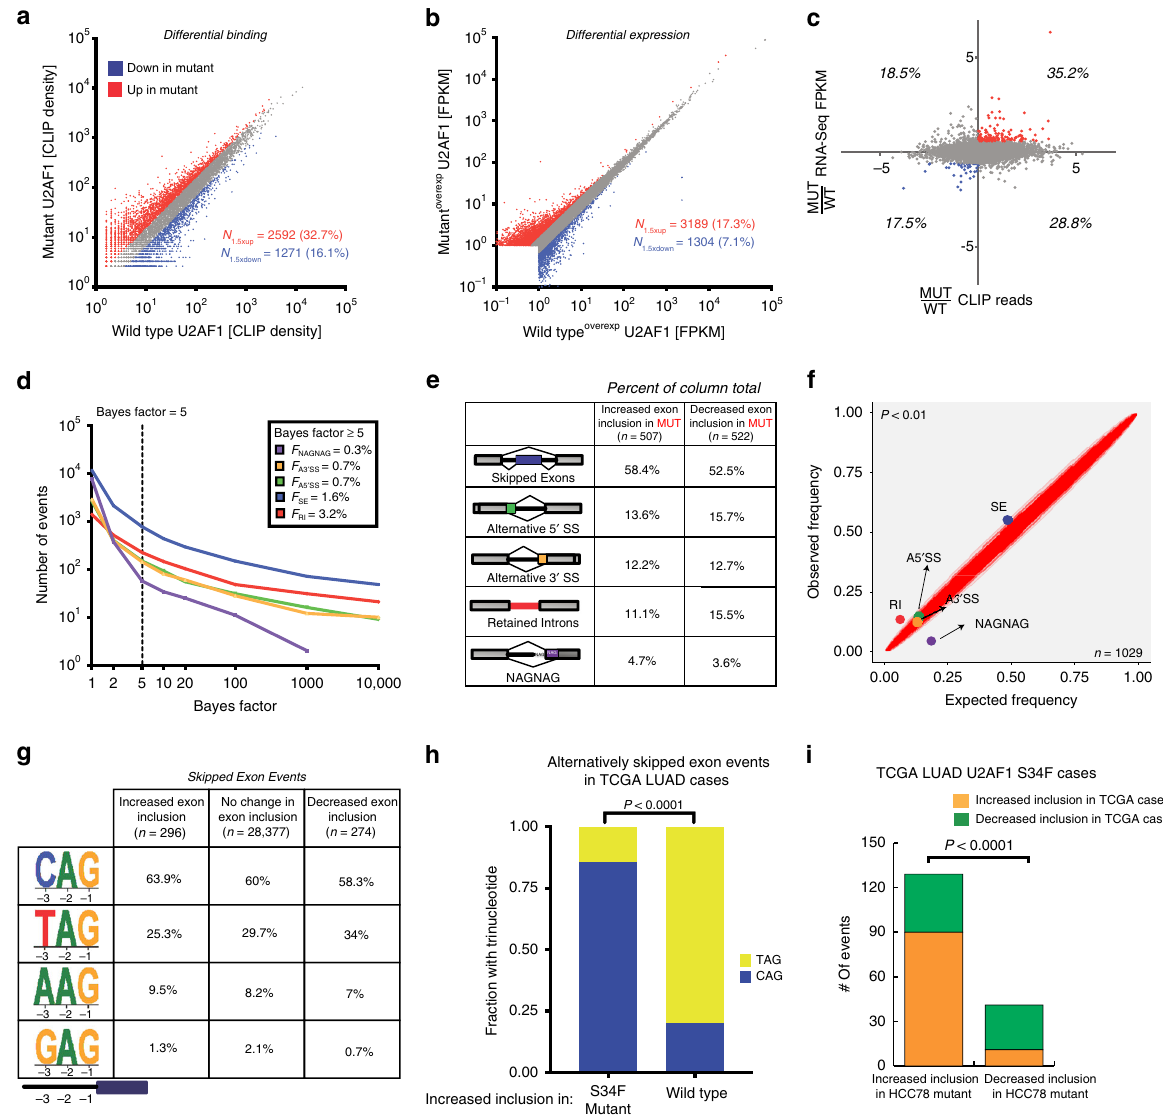
Fig. 4 Global binding and expression differences in wild-type and mutant U2AF1. a U2AF1 S34F globally alters binding in HCC78. Scatter plots comparing CLIP reads of individual genes bound to wild-type and mutant U2AF1. Genes that were preferentially bound (fold change >1.5) in favor of mutant (red) and wild-type (blue) are shown. b U2AF1 S34F globally alters expression in HCC78. Scatter plots comparing FPKM values of individual genes bound to wild-type and mutant U2AF1. Genes that were preferentially expressed (fold change >1.5) in favor of mutant (red) and wild-type (blue) are shown. c Comparison of mutant to wild-type ratios U2AF1 CLIP reads and FPKM values of individual genes. 87 genes for mutant and 23 genes for wild-type are shown to be differentially bound and expressed in favor of the mutant and wild-type, respectively. d Cumulative frequencies of alternative splicing events. A statistically signi fi cant threshold for alternative splicing events comparing wild-type and mutant U2AF1 (Bayes factor >5) is shown. A3 ′ SS, alternative 3 ′ SSs; A5 ’ SS, alternative 5 ’ splice sites; SE, skipped exons; RI, retained introns. e Alternative splicing events preferentially spliced in favor of mutant or wild- type U2AF1 at greater than 10% frequency (Bayes factor >5). Δ PSI = difference in “ percentage spliced in ” . f Scatter plot comparison of expected alternative splicing events and observed events as a percentage of all events. Gray area represents statistically signi fi cant region with P < 0.01. g The frequency of each trinucleotide at 3 ′ splice sites of alternatively skipped exons in U2AF1 S34F mutant and wild-type transduced cells based on their change in inclusion. h Fraction of skipped exon events with TAG or CAG at the 3 ′ splice site in wild-type and U2AF1 S34F mutant TCGA LUAD cases ( n = 175 for wild-type and 125 for mutant). i Overlap of differentially skipped exon events in HCC78 (Z-score of ψ greater/less than ±1.64, P = 0.05) and TCGA U2AF1 S34F mutant LUAD cases ( P =